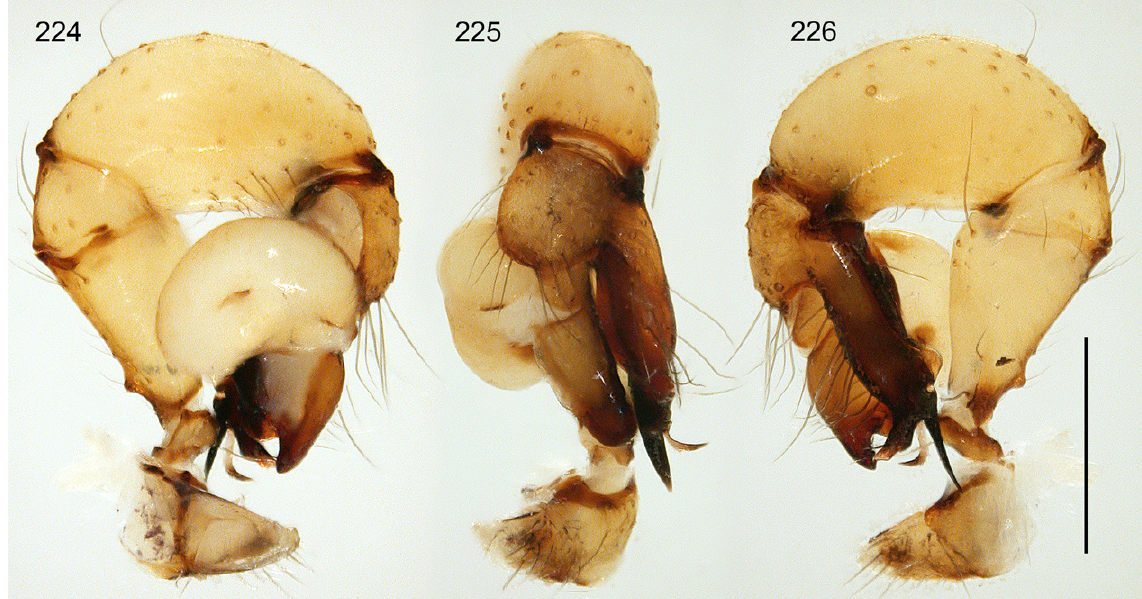
left palp, prolateral, dorsal, and retrolateral views. Scale bar = 0.5